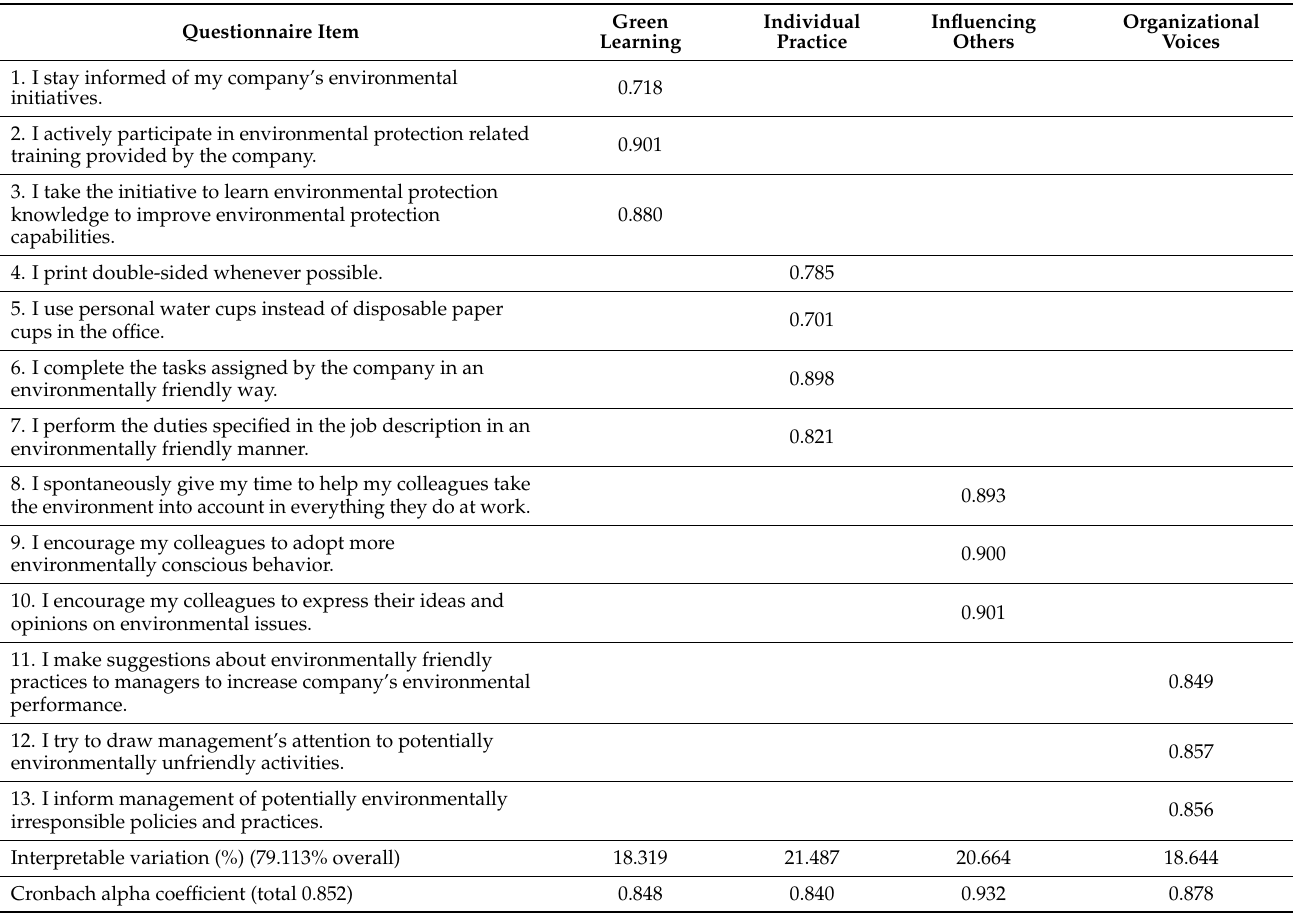
Table 1. Four-dimensional exploratory factor analysis results of employee green